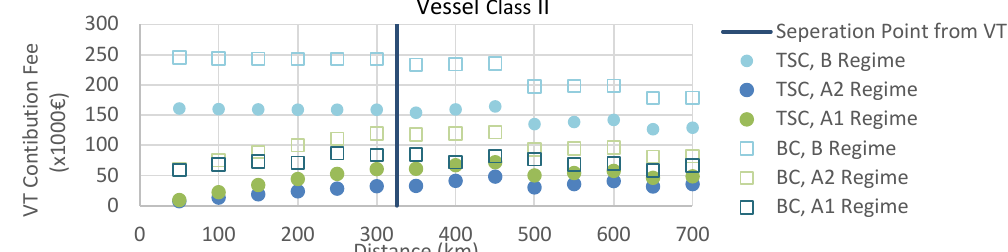
Figure 12: VT Contribution Cost For Vessel Class II